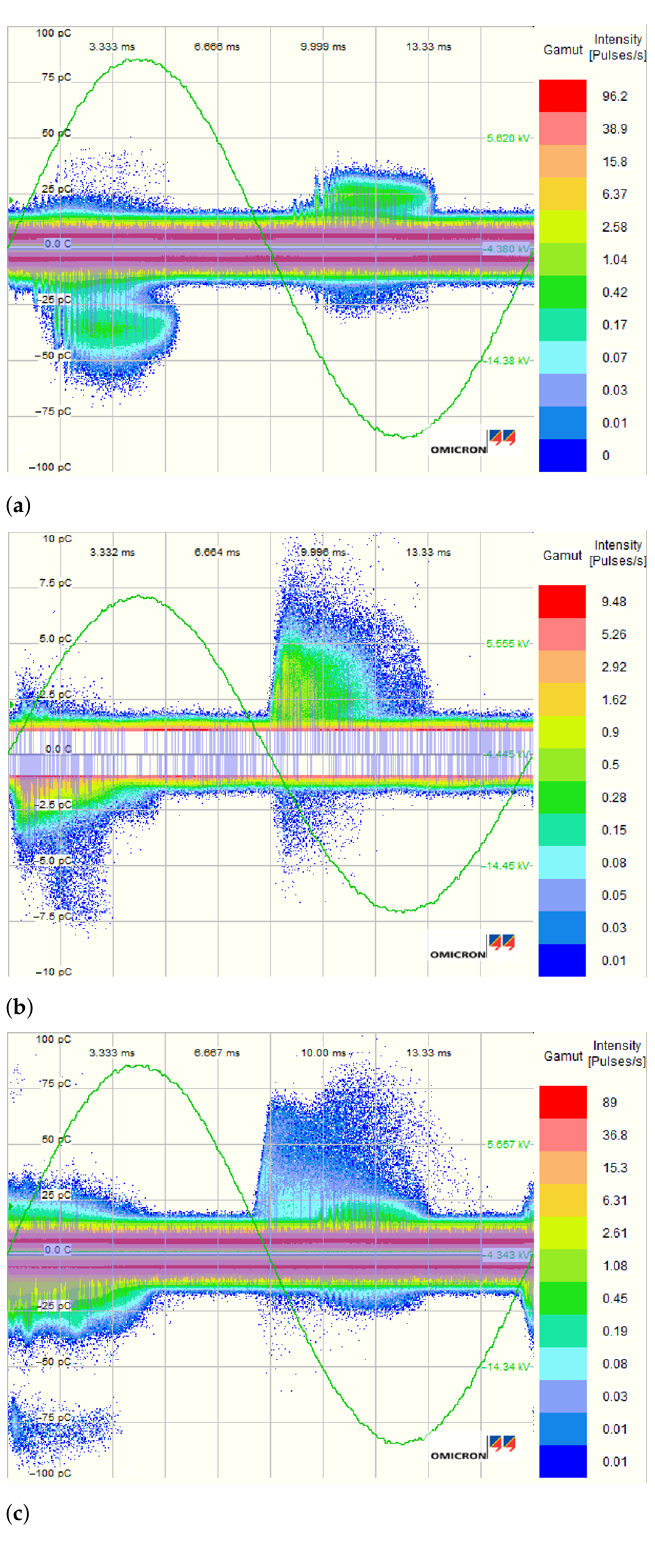
Figure 13. PRPDs experimentally obtained in this work for: ( a ) corona (12 kV—General Electric bar), ( b ) slot (10 kV—Jeumont-Schneider bar), and ( c ) simultaneous corona and slot (12 kV) obtained usingboth